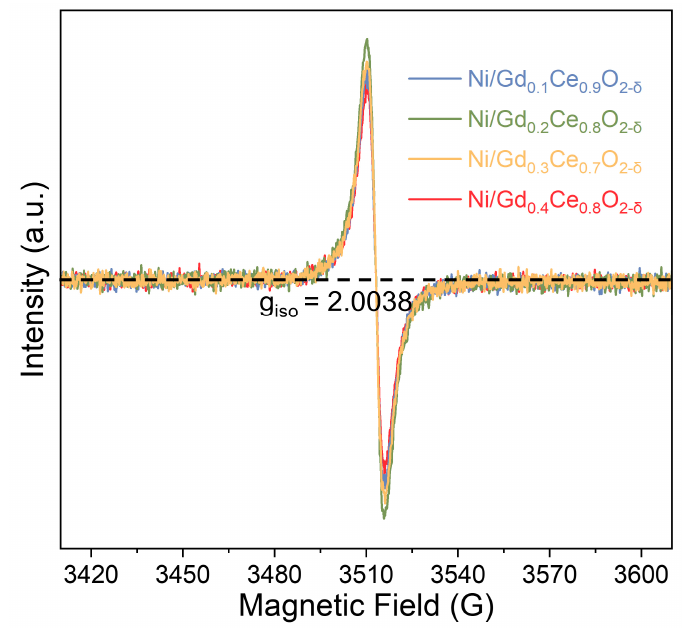
Figure 2. EPR profiles of the reduced Ni/Gd x Ce 1-x O 2- δ support.